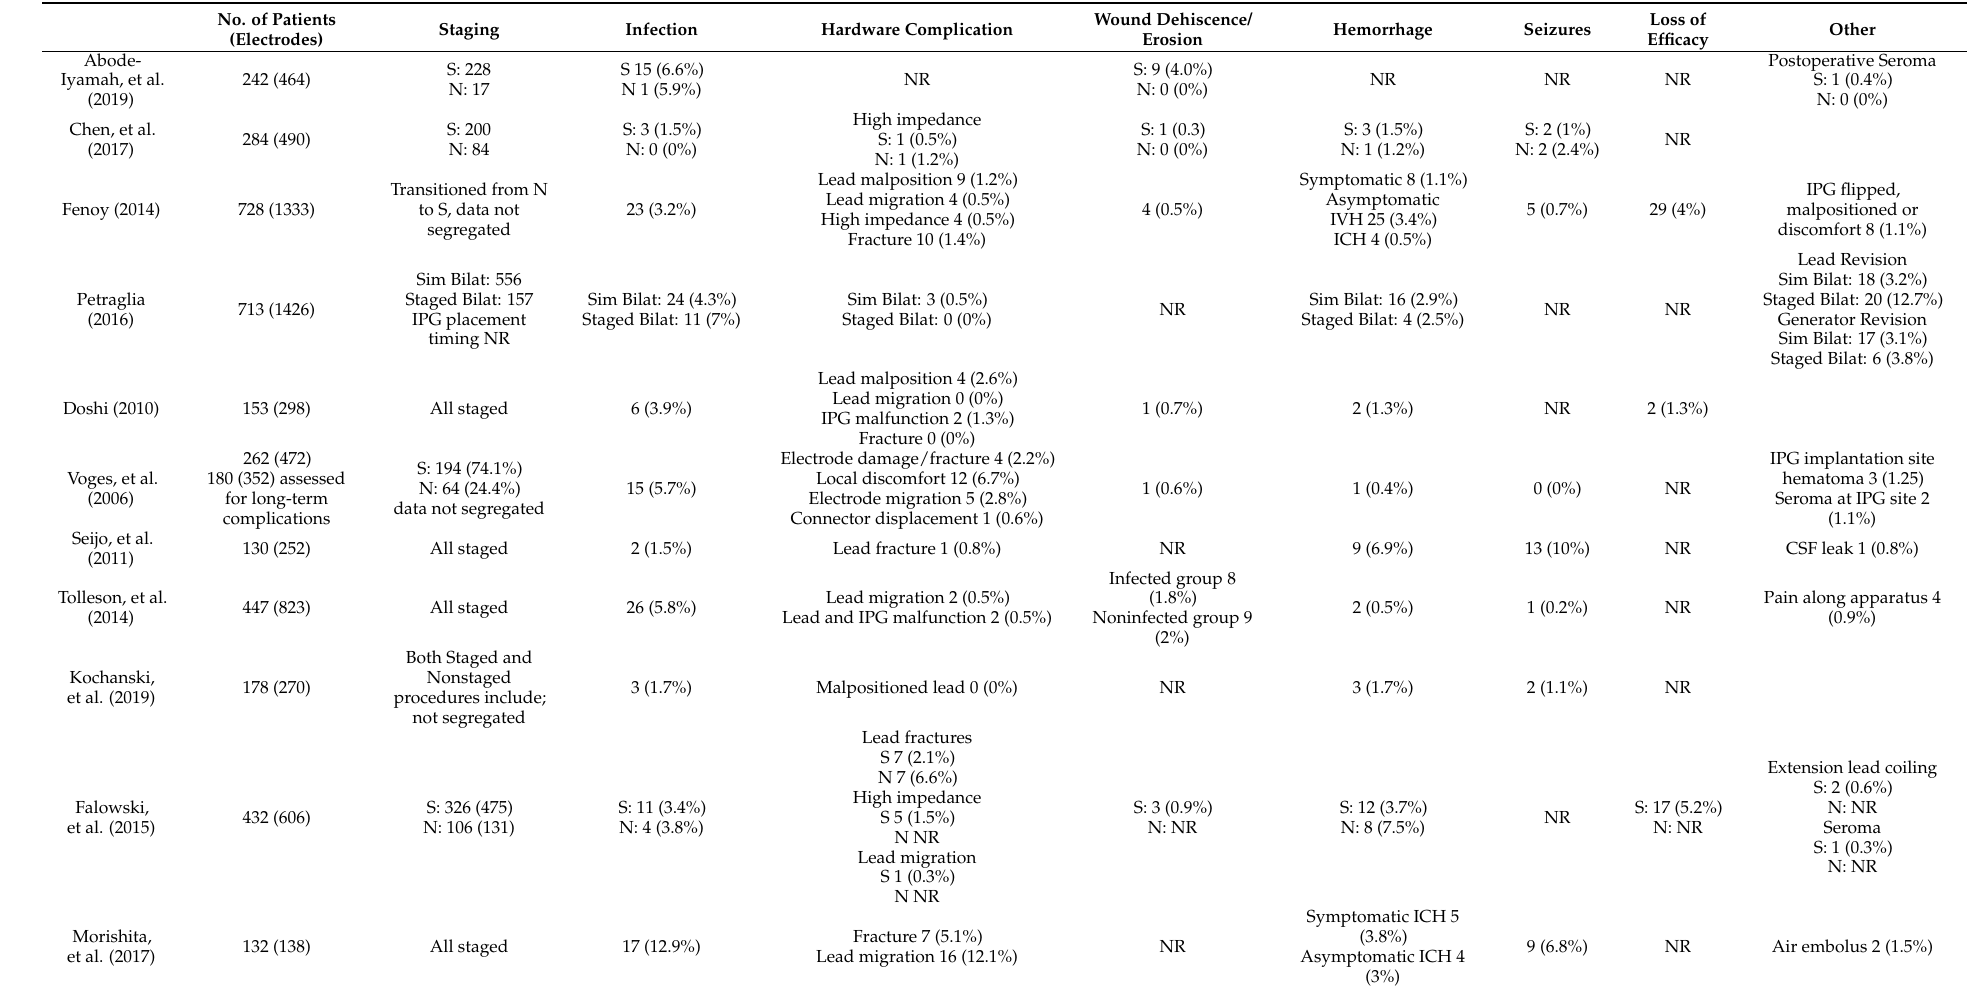
Table 3. Complications in other published